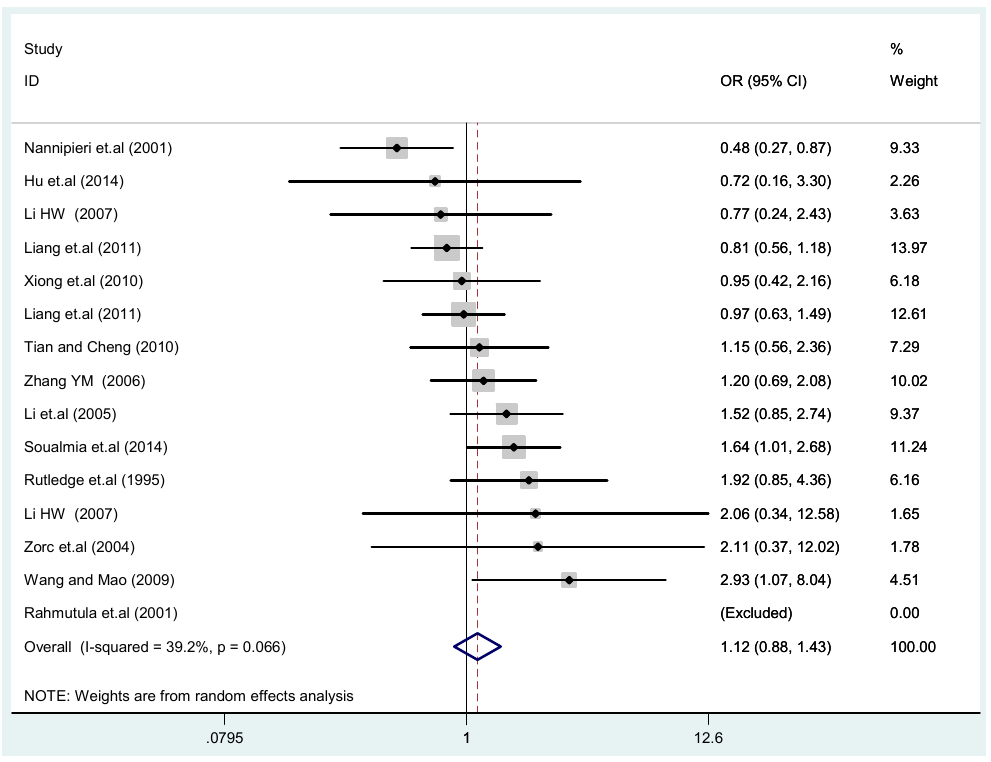
Figure 5. Forest plot of overall population of T2238C dominant model (CC + TC) vs. TT. Int. J. Environ. Res. Public Health 2016 , 13 , 458